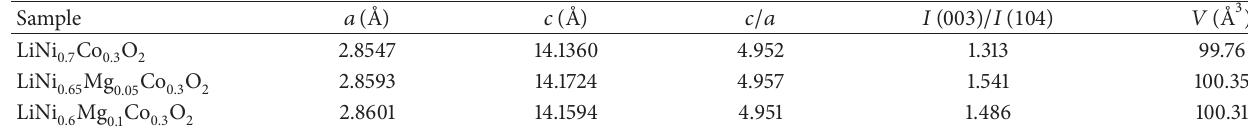
Table 1: Results of lattice parameters by XRD analysis of LiNi 0.7−𝑥 Mg 𝑥 Co 0.3 O 2 ( 0 ≤ 𝑥 ≤ 0.1